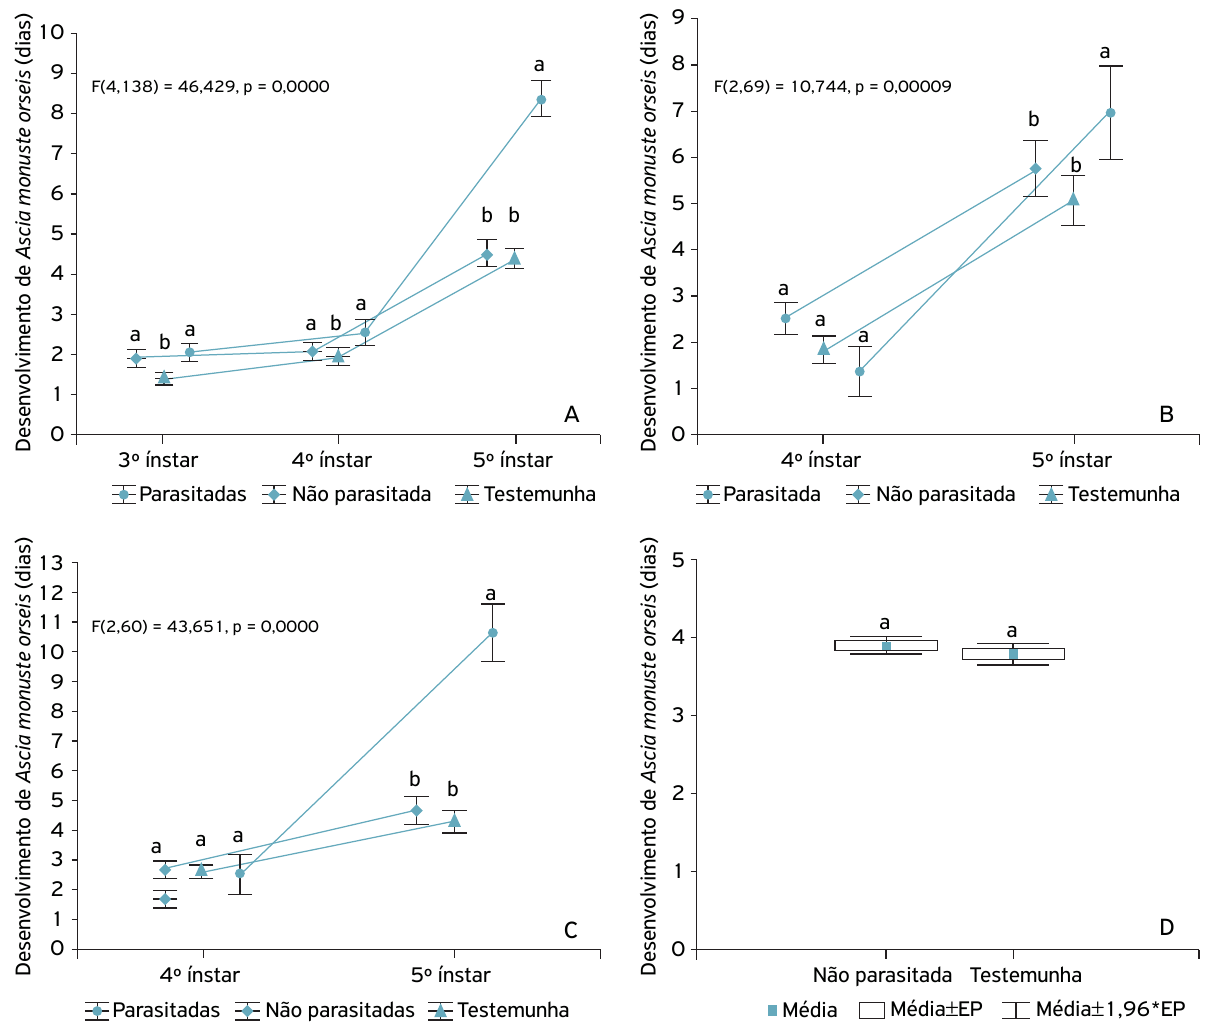
Figura 1. Duração média ( ± IC) de ínstares de Ascia monuste orseis submetidas ao parasitismo de Cotesia glomerata em diferentes ínstares: 2 o (A), 3 o (B), 4 o (C) e 5 o (D).